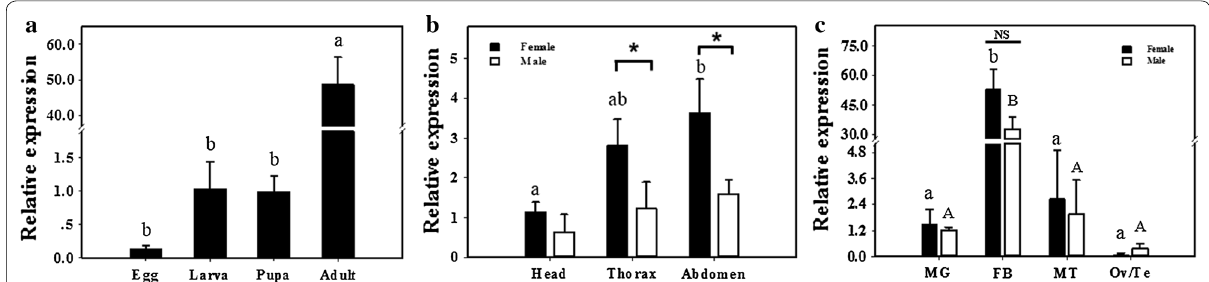
Fig. 4 The spatiotemporal expression profiles of BdPho in B. dorsalis . a The relative mRNA expression profiles of BdPho in egg, third instar larva, 5‑day‑old pupa and 5‑day‑old adult; b The relative mRNA expression profiles of BdPho in various body parts including head, thorax and abdomen; c The relative mRNA expression profiles of BdPho in different tissues including Malpighian tubule (MT), fat body (FB), mid gut (MG), ovary (Ov) and testis (Te). Data are presented as mean SE ( n 4). Lowercase letters above black bars and uppercase letters above white bars indicate statistical ± = difference by ANOVA followed by the Tukey’s multiple comparison test ( P < 0.05), respectively. Significant differences between female and male determined with t ‑test, asterisks indicate significant differences in relative expression (* P < 0.05; ** P < 0.01), and NS means no significant